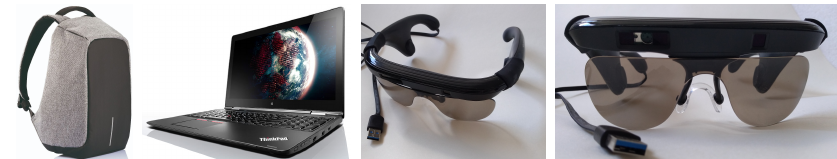
Figure 3. Hardware components used in our prototype. From left to right: a lightweight backpack, a Lenovo Thinkpad Yoga 14 laptop and the KR-Vision glasses. The glasses house bone-conducting headphones, better seen in the third image from the left as the protuberances in the temple pieces. The RGB-D camera, made by Intel, is housed inside the thick bezel above the lenses, best seen in the rightmost